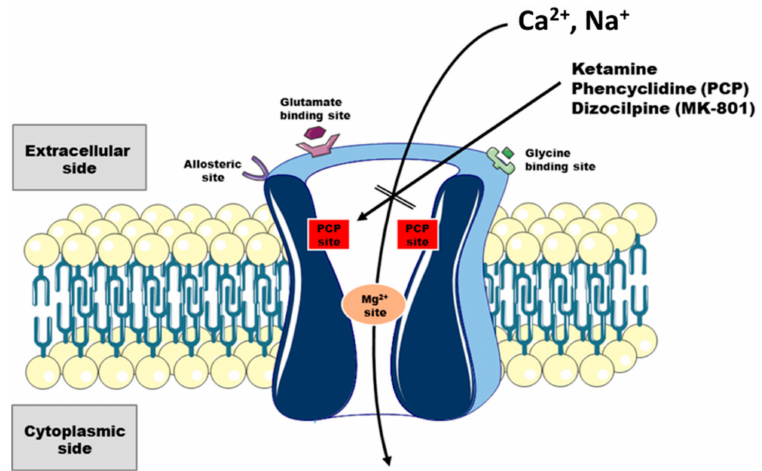
Figure 1. Schematic model of ketamine interaction with NMDA receptor. NMDA receptors are glutamatergic, ligand-gated ion channels comprising of four subunits forming a central pore that is permeable for Ca 2 + . Up to date, seven di ff erent subunits have been identified: GluN1, GluN2A, GluN2B, GluN2C, GluN2D, GluN3A and GluN3B. However, NMDA receptor is typically composed of two GluN1 and two GluN2 subunits or a mixture of GluN2 / GluN3 subunits. At resting state, the pore is occupied by Mg 2 + , but upon depolarization, the magnesium block is removed allowing Ca 2 + to enter the cell. Besides depolarization, the activation of the receptor requires concurrent binding of L-glutamate and glycine / D-serine. Pore opening makes it accessible to ketamine which binds to PCP site and blocks further Ca 2 + influx. The (S)-enantiomer of ketamine binds to the same site. In addition to ketamine and glutamate / glycine binding sites, several other known sites for regulation have been identified in NMDA receptor and they are reviewed in